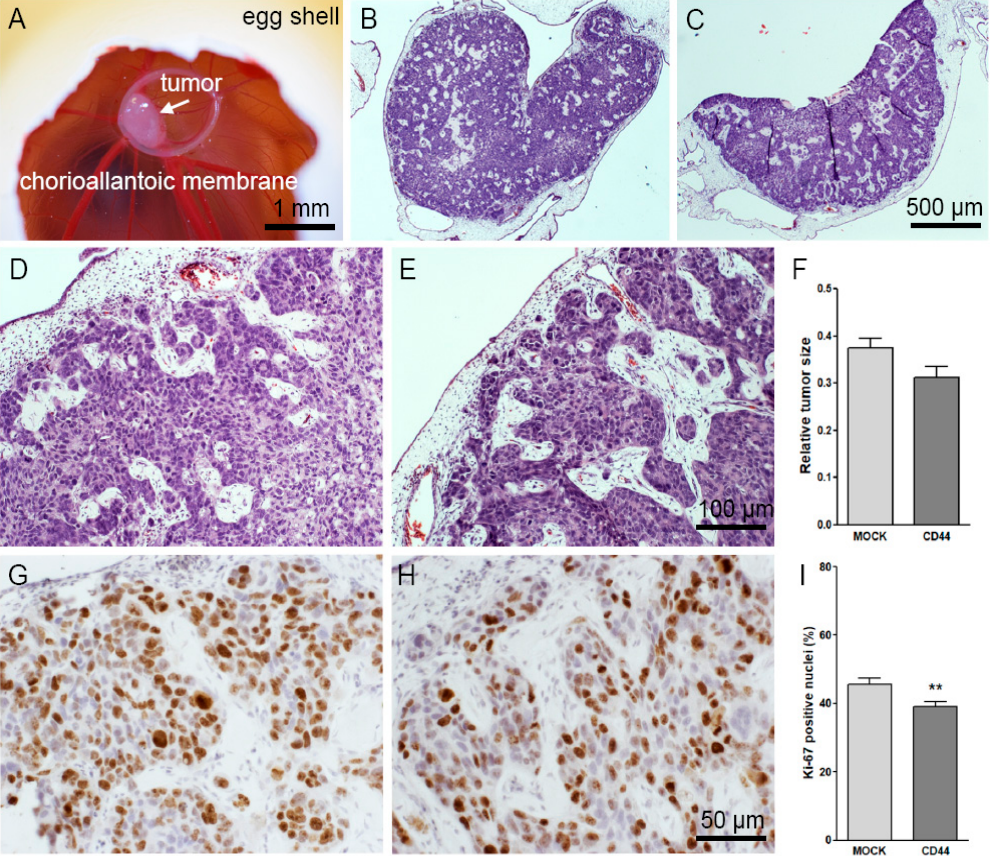
Figure 6. Analysis of growth, morphology and proliferation of MKN74 tumors in CAM assays. A typical example of MKN74-derived CAM tumor (EDD13) is shown in ( A ). Whole sections of HE-stained tumors from MOCK and CD44-positive cells are shown in ( B , C ), correspondingly. Higher magnification images from HE-stainings show the overall morphology of MOCK ( D ) and CD44-positive ( E ) tumor tissues. The relative tumor size of both groups is shown in ( F ). Representative images of Ki-67-stainings (brown) of MOCK ( G ) and CD44-positive ( H ) tumor sections. The proportion of Ki-67-positive nuclei in both tumor groups is shown in ( I ); n = 20 in both groups. ** p <